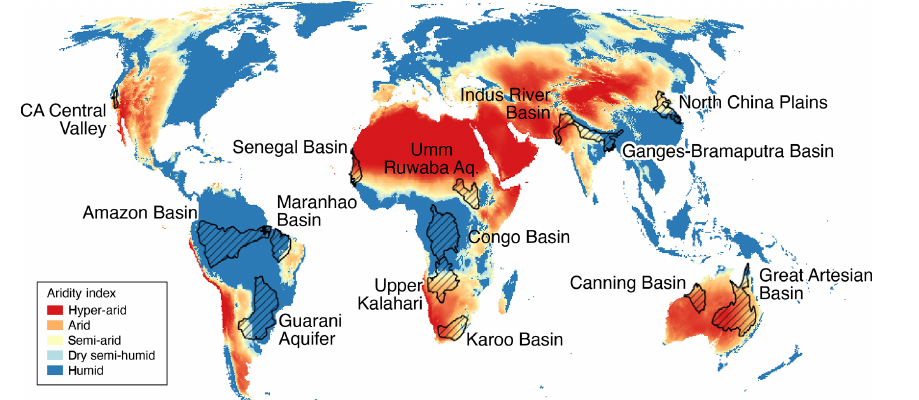
Figure 1. The 14 selected world large-scale aquifers (the study aquifers) overlaid on the CGIAR-CSI Global Aridity Index dataset (Trabucco and Zomer,